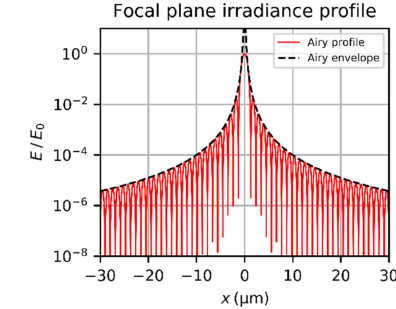
Figure 3. Normalized irradiance profile of an Airy di ff raction pattern and its envelope according to Equation (7) and Equation (12), respectively. Calculation parameters: λ = 532 nm and an f -number of F =